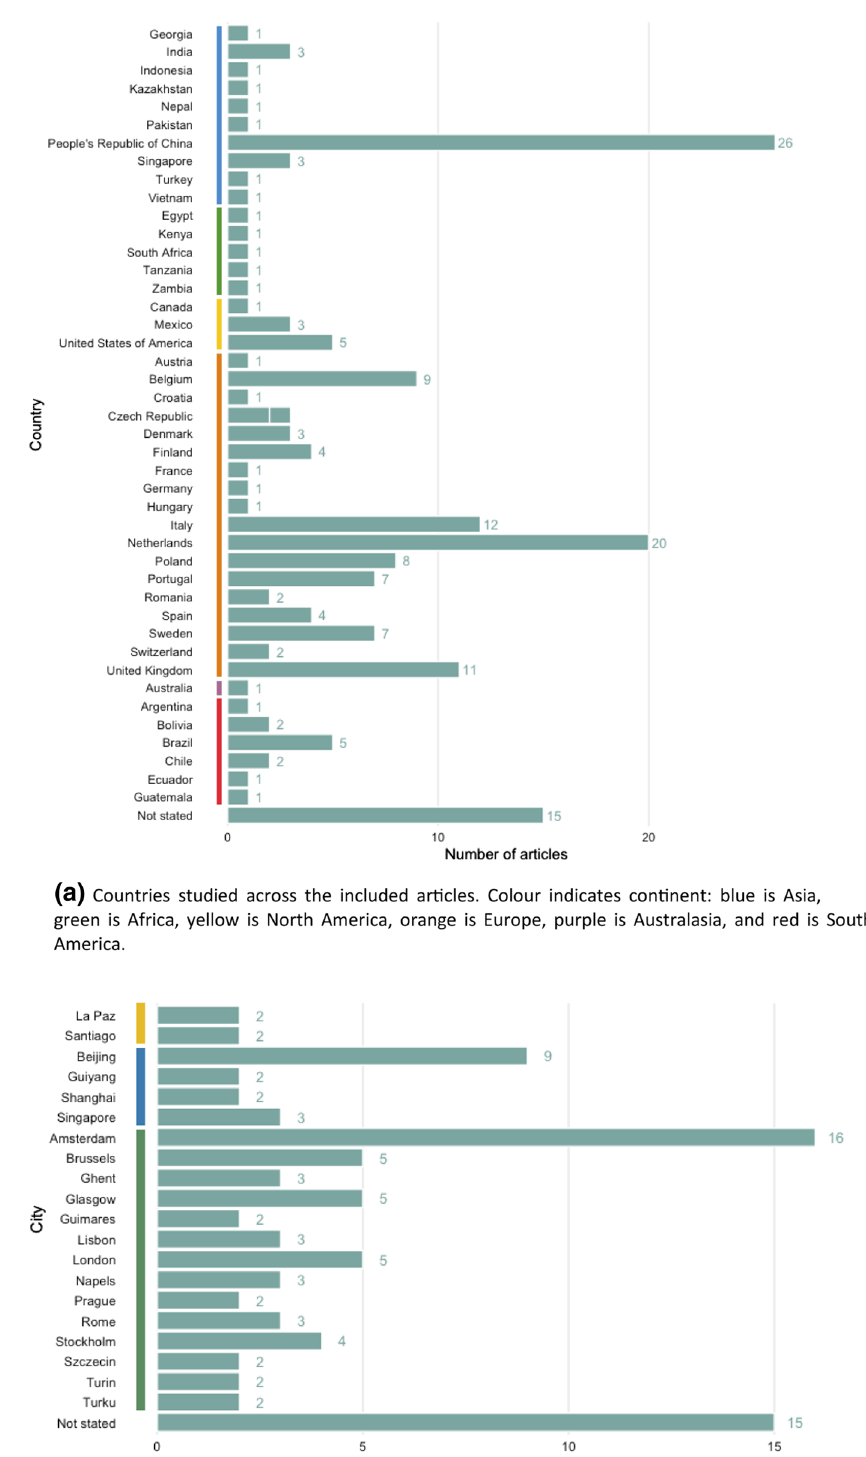
Fig. 4 a Countries studied across the included articles. Colour indicates continent: blue is Asia, green is Africa, yellow is North America, orange is Europe, purple is Australasia, and red is South America. b The cities described across the 178 included articles; yellow is South America, blue is Asia, green is Europe. Cities shown are those reported in more than one article.